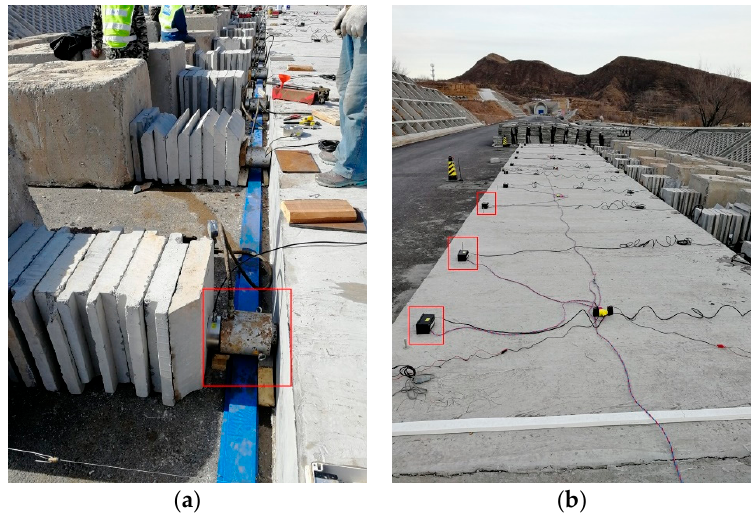
Figure 2. Test setup of full-scale plate-pushing test. CCBP: cement concrete base plate. ACWL: asphalt concrete waterproofing layer.